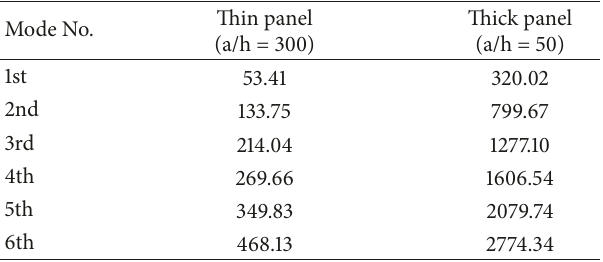
Table 1: Natural frequencies of thin and thick square panels (units: Hz).